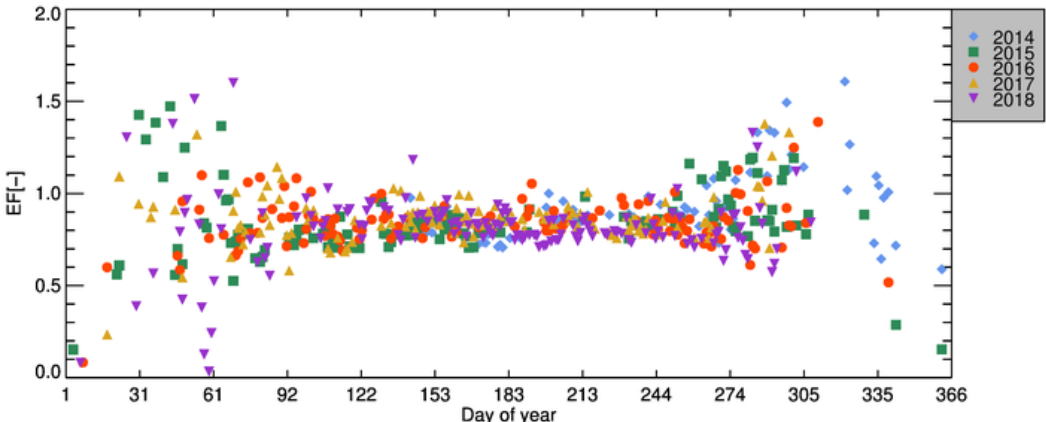
Figure 6. Seasonal progression of the EF24 (daily mean EF from 00:00 to 24:00) at the site Veenkampen for the period Jun 2014 to Oct 2018.